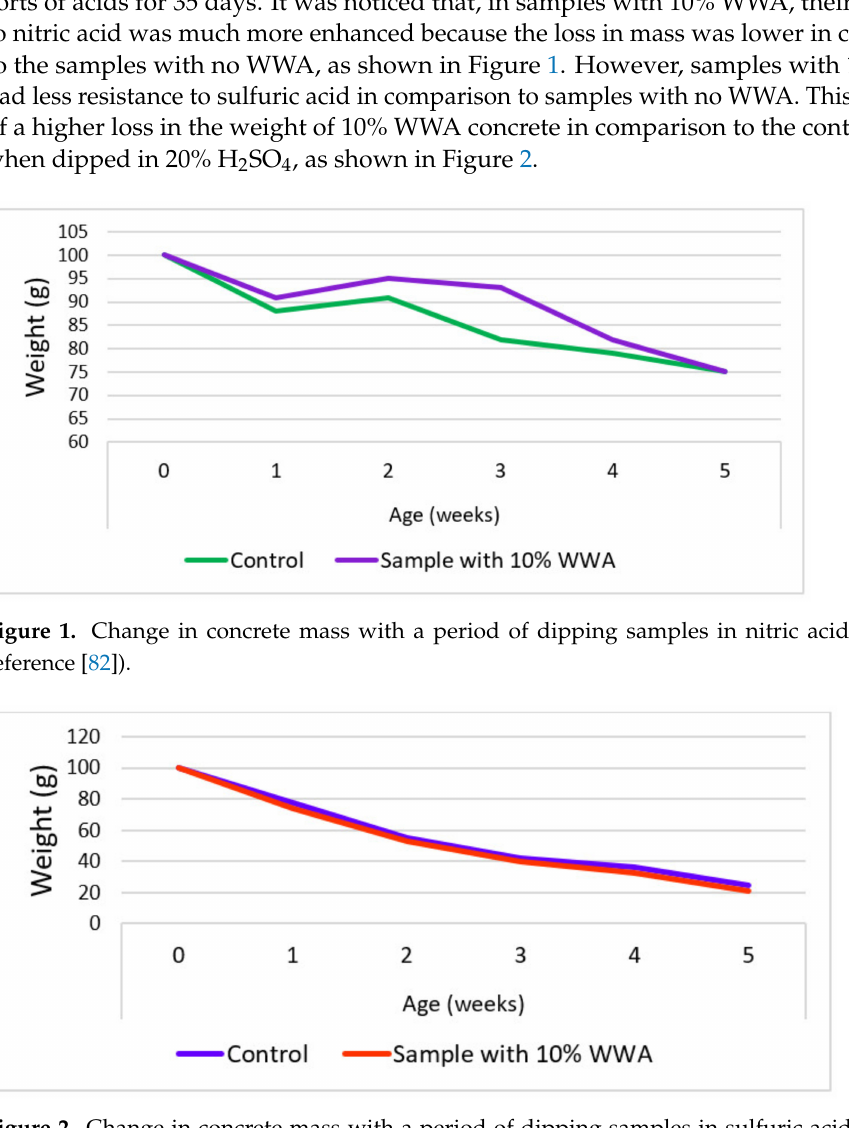
Figure 2. Change in concrete mass with a period of dipping samples in sulfuric acid (data from reference